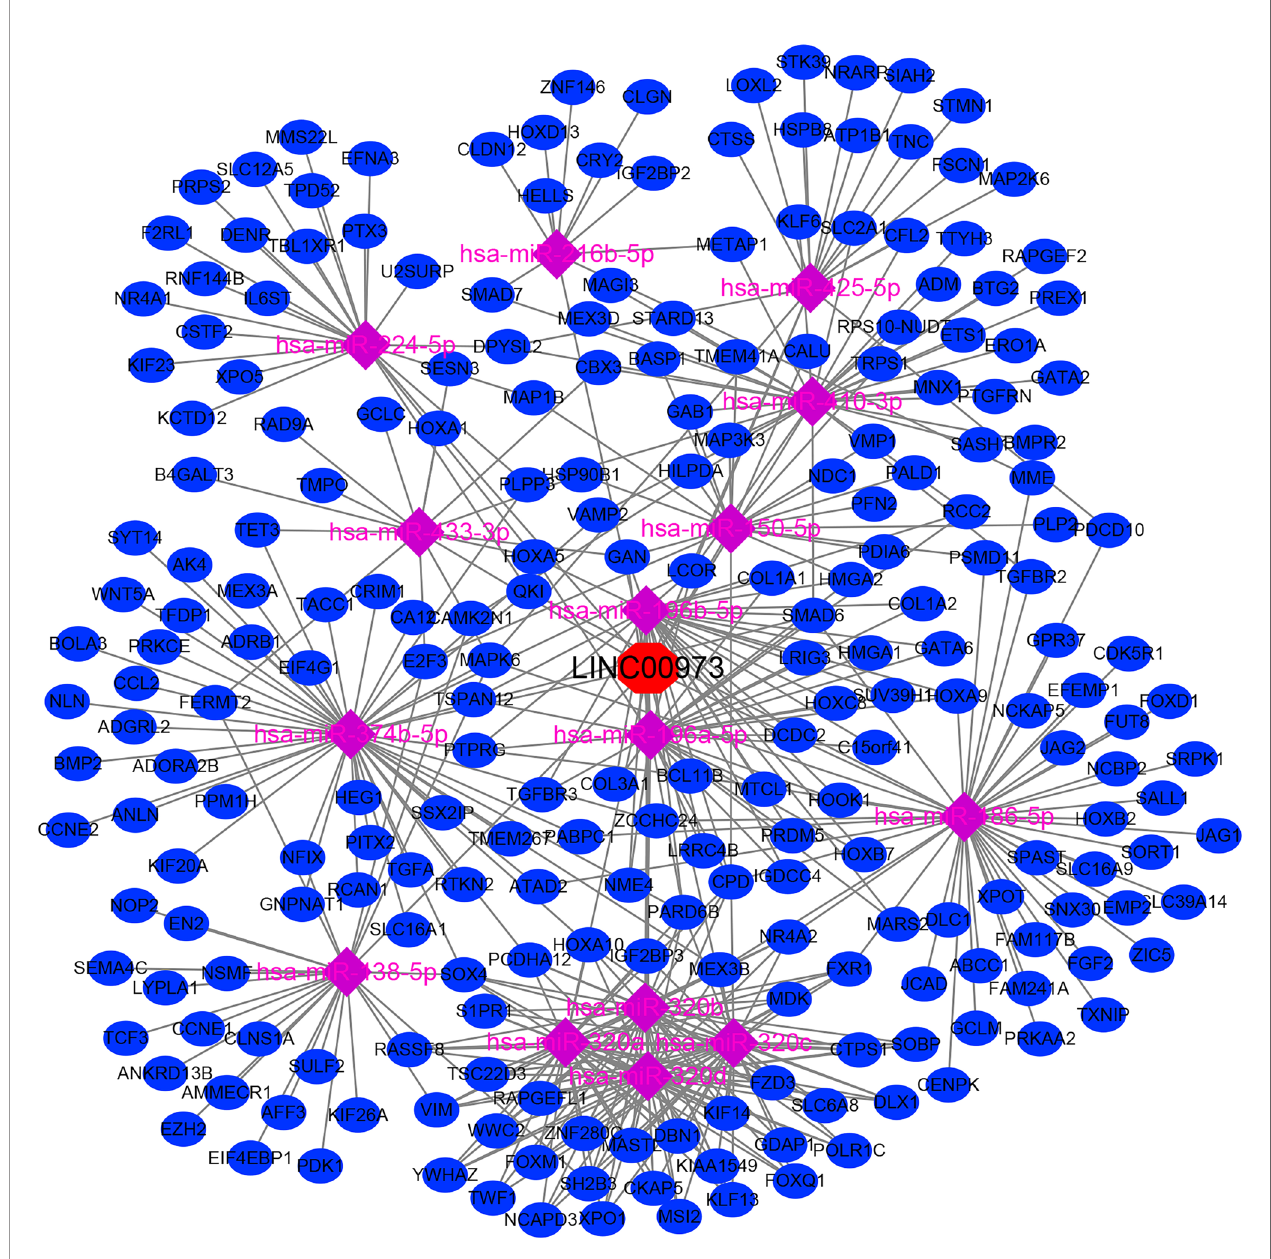
FIGURE 5 | The LINC0097-miRNA-mRNA ceRNA network signaling